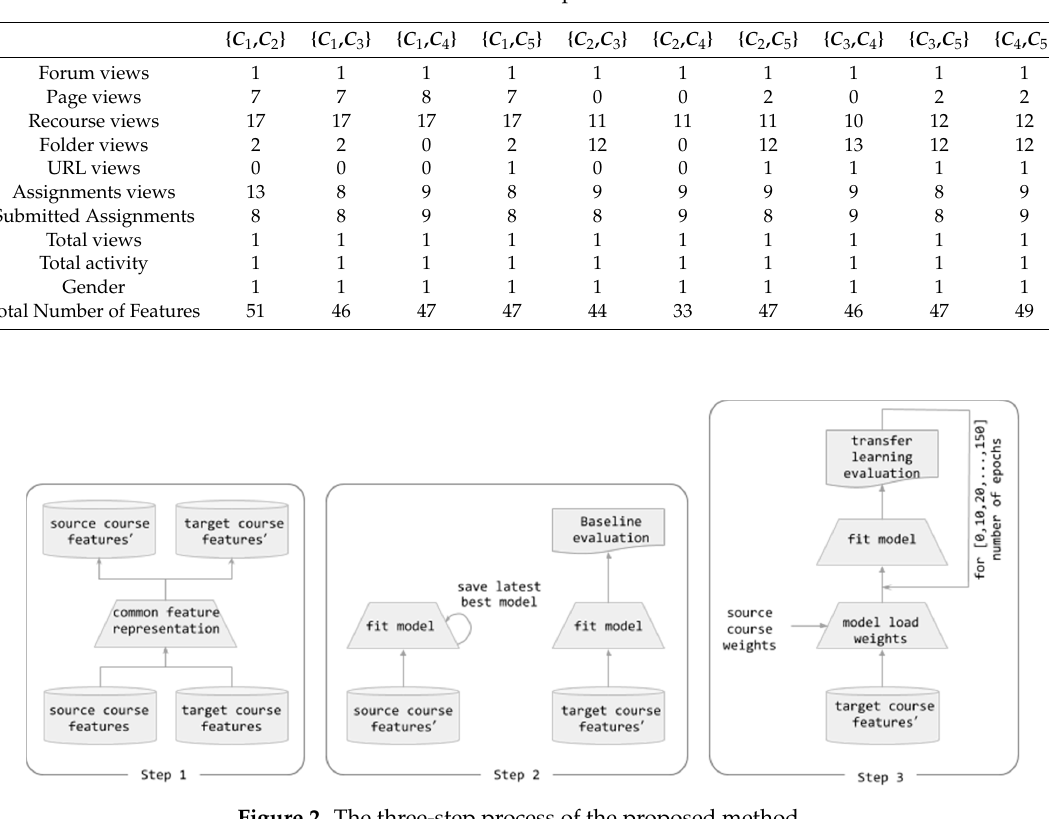
Table 3. Features of the paired datasets.